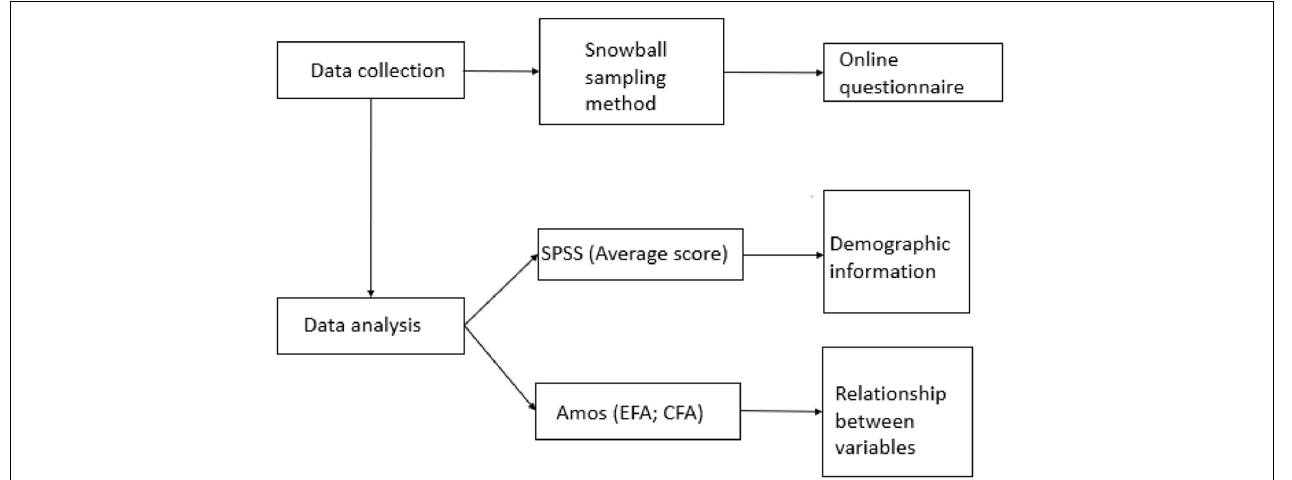
FIGURE 1 | Data collection and analysis